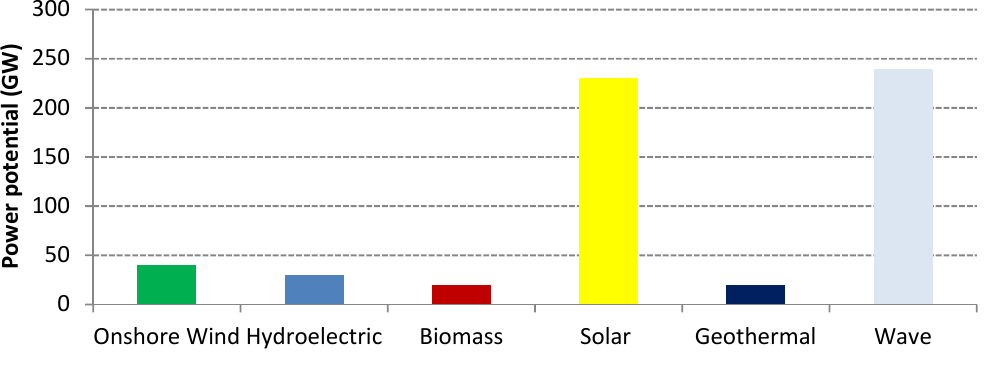
Figure 1. Estimated Potential of RES in Chile. Source: [34] and the authors’ own